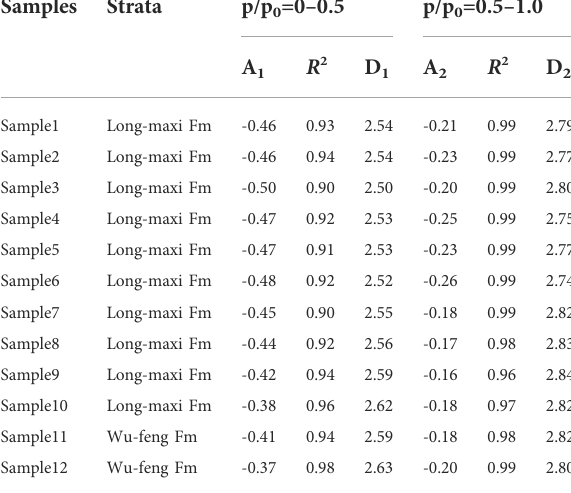
TABLE 4 Fractal dimensions derived from the FHH